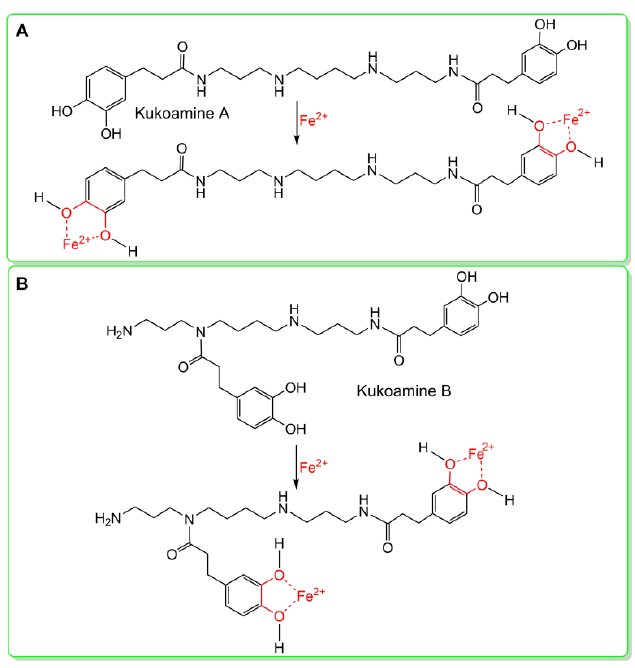
Figure 7. The proposed chelation reactions of kukoamine A ( A ) and kukoamine B ( B ) with excessive Fe 2+ .